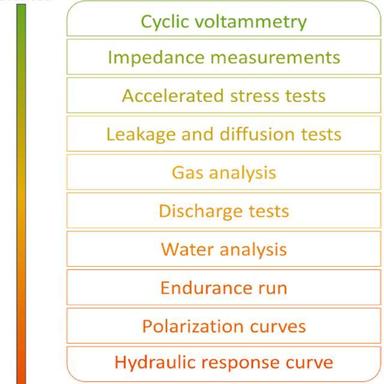
Characterization methods for electrolysis stacks.